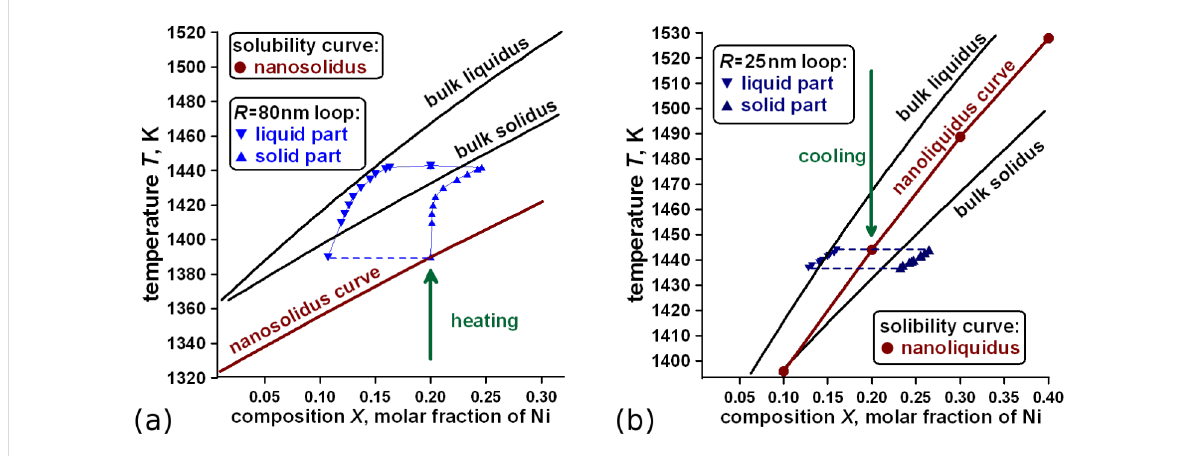
Figure 4: (a) – Nanomelting loop at T–X diagram of 80 nm Cu–Ni nanoparticle showing the difference between the compositional loop of two-phase states (two-phase equilibrium states indicated by blue triangle symbols ‘top down’ for liquid part and ‘top up’ for solid part) and solubility curve – nanosolidus (size-dependent solidus curve as starting points of phase transformation indicated by the brown line). (b) – nanosolification loop (indi- cated by blue triangle symbols ‘top down’ for liquid part and ‘top up’ for solid part) at T–X diagram of 25 nm Cu–Ni nanoparticle and solubility curve – nanoliquidus (indicated by brown points and line). Composition X is the molar fraction of Ni